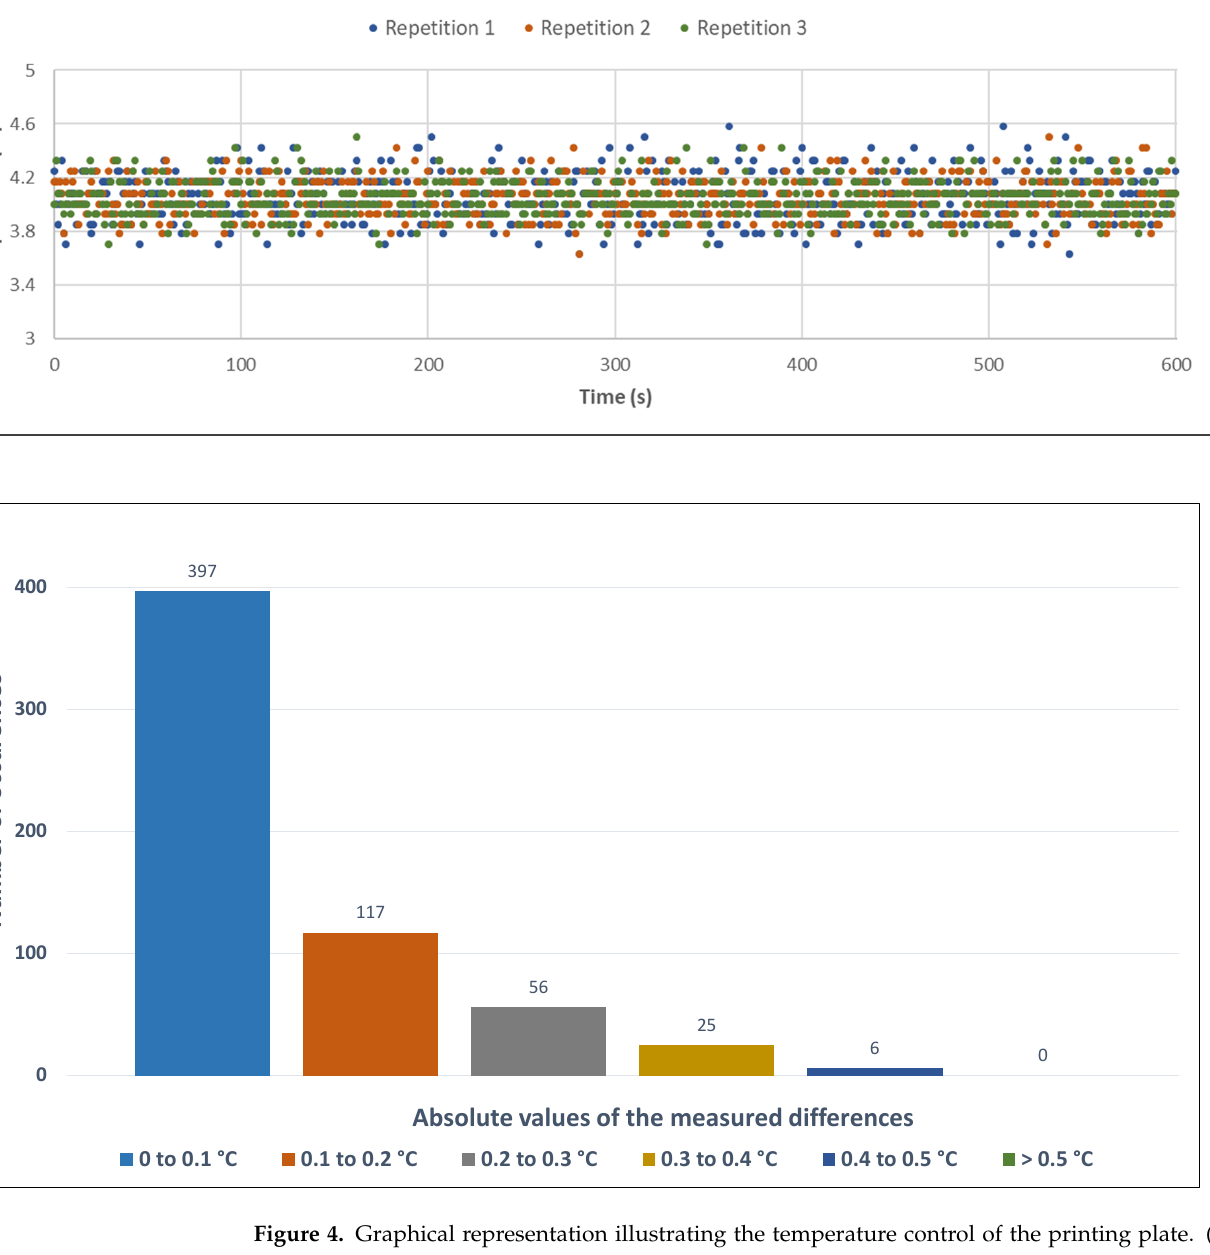
Figure 4. Graphical representation illustrating the temperature control of the printing plate. ( A ) Stability over 600 s for a setpoint temperature of 4 °C and one measurement per second. ( B ) Data distribution according to the absolute value of their deviation from the setpoint.